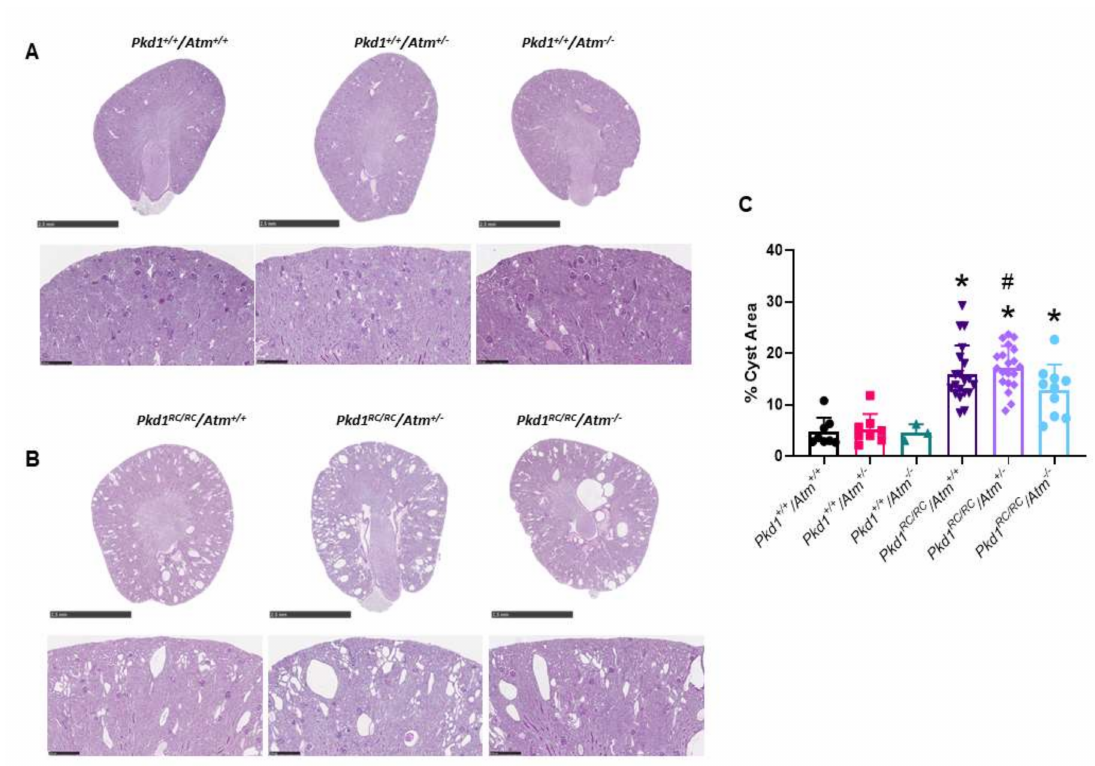
Figure 7. Effect of loss of ATM on renal histology in Pkd1 RC/RC mice at 3 months of age. ( A , B ) Representative whole-slide digital images of Periodic Acid Schiff (PAS)-stained kidney sections from male wild-type ( A ) Pkd1 RC/RC ( B ) mice. Scale bars in top panel indicates 2.5 mm and bottom panel 0.25 mm. ( C ) Mean percentage cyst area in the experimental groups calculated as the percentage of white area (no stain) in the total cortical area. * p < 0.05 compared to wild-type mice ( Pkd1 +/+ /Atm +/+ ) and # p < 0.05 compared to Atm genotype matched Pkd1 +/+ . Data presented as means ± SD ( n = 8 per wild-type group; n = 4 males and n = 4 females; n = 20 per Pkd1 RC/RC mouse group; n = 10 males and n = 10